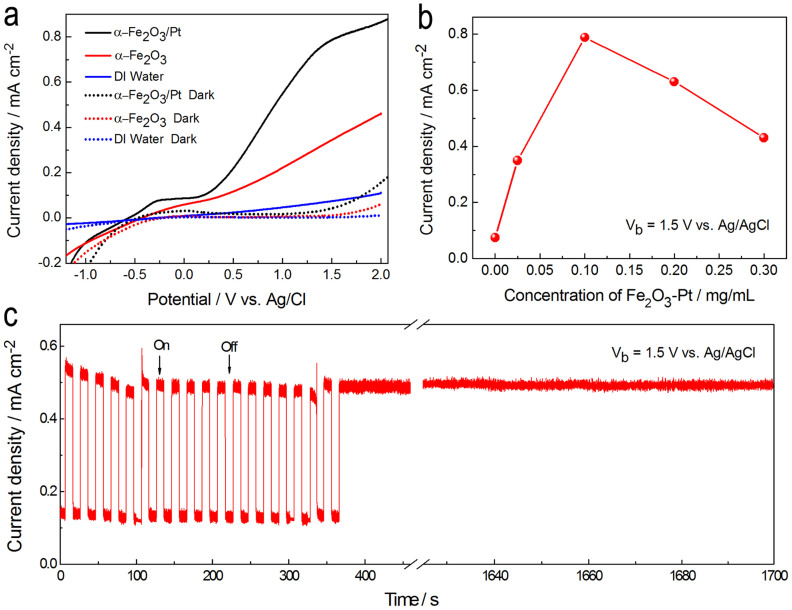
Photoelectrochemical properties.(a) J–V curves of TiO2/In2S3/AgInS2 in different electrolytes of 15 MΩ DI water, 15 MΩ DI water with α−Fe2O3/NPs and 15 MΩ DI water with α−Fe2O3/Pt NPs in the dark and under illumination. (b) α−Fe2O3/Pt concentration−dependent behavior of current density at Vb = 1.5 V vs. Ag/AgCl. (c) J–t curve of TiO2/In2S3/AgInS2 in DI water containing 0.1 mg/mL α−Fe2O3/Pt under chopped illumination at a bias of 1.5 V vs. Ag/AgCl. The inset in (c) shows the evolution of H2 during the J–t curve measurement.